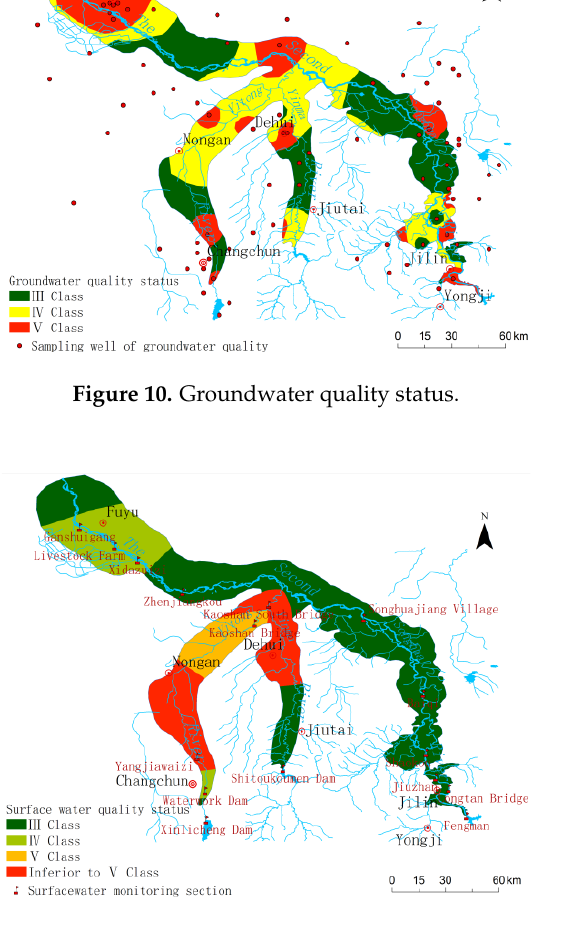
Figure 11. Surface water quality status.